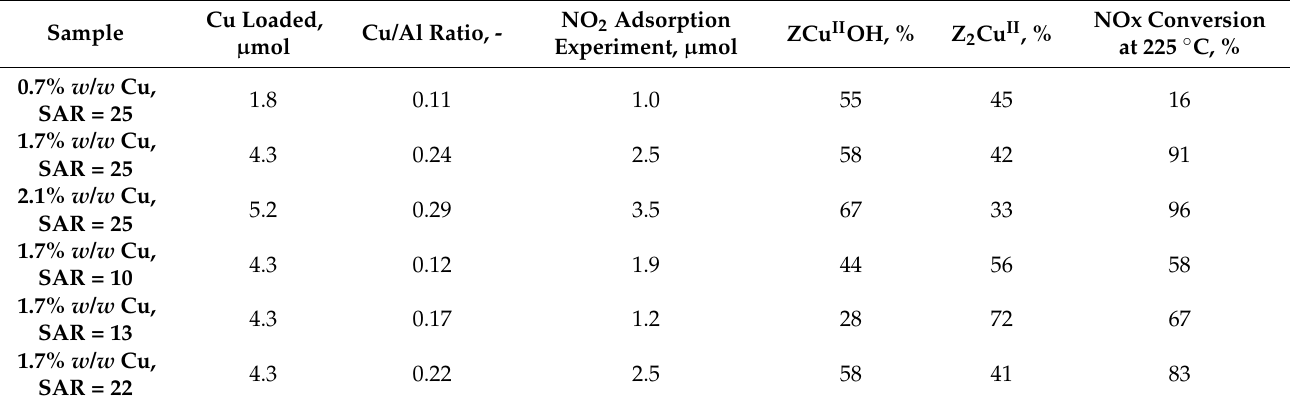
Table 3. Characterization of the tested catalyst samples